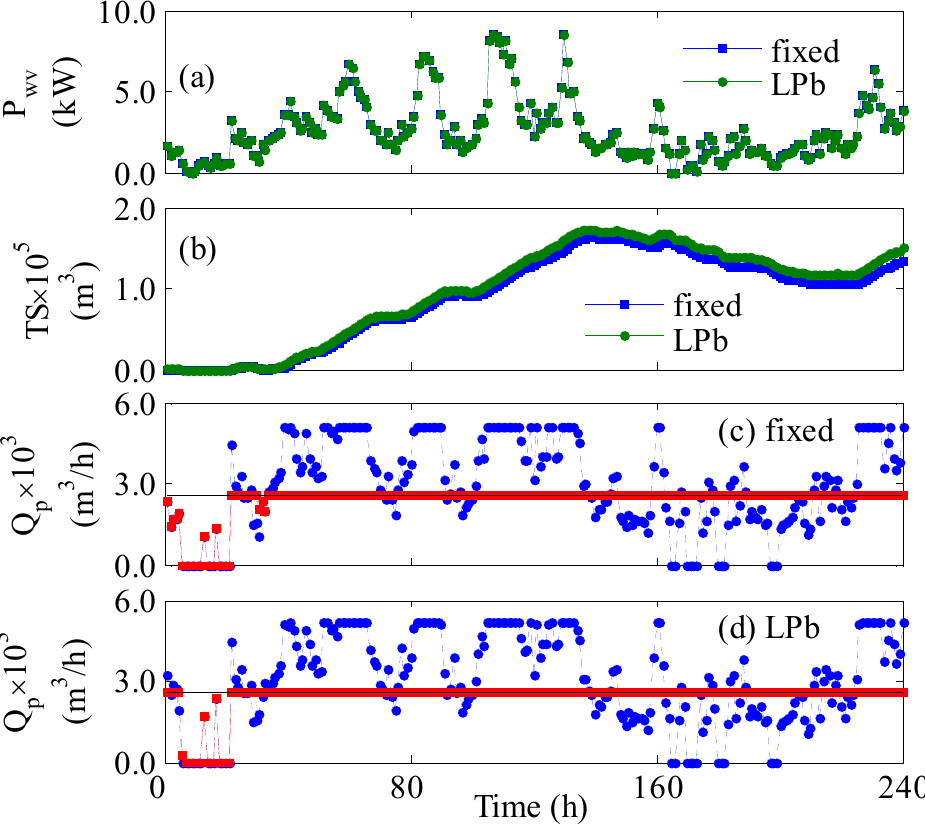
Figure 6. Plant dynamic response for 10 days under nominal conditions; ( a , b ) square marker: fixed, circle marker: LPb ; ( c , d ) solid line: Q s p ; blue circle: Q p ; red square: Q r p